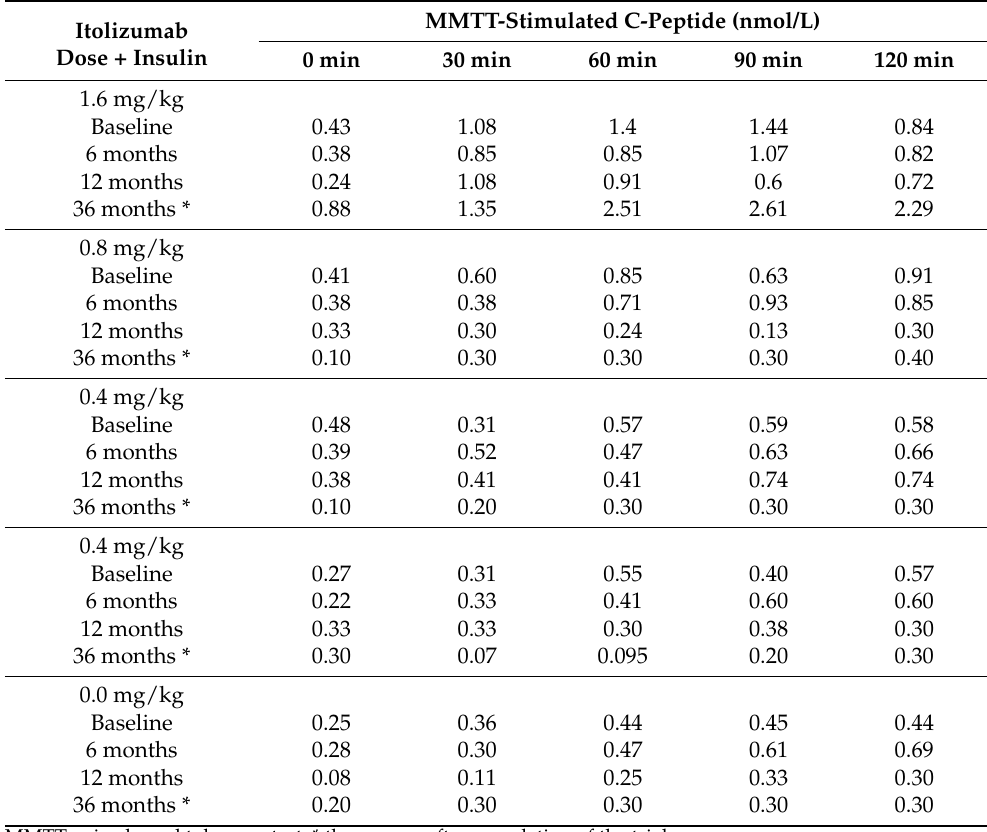
Table 3. Levels of MMTT-stimulated C-peptide in five patients during the combination treatment of Itolizumab and insulin and three years after completion of the